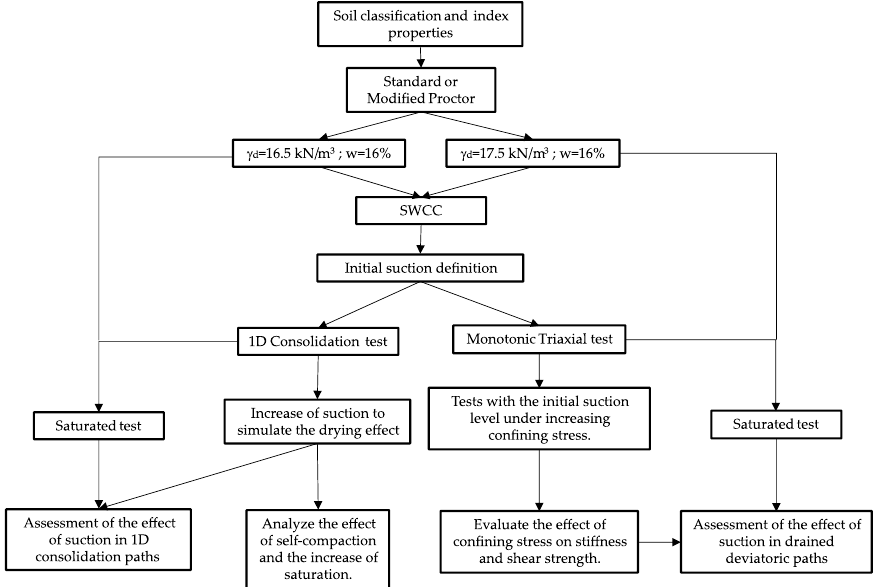
Figure 5. Flowchart of the experimental program.